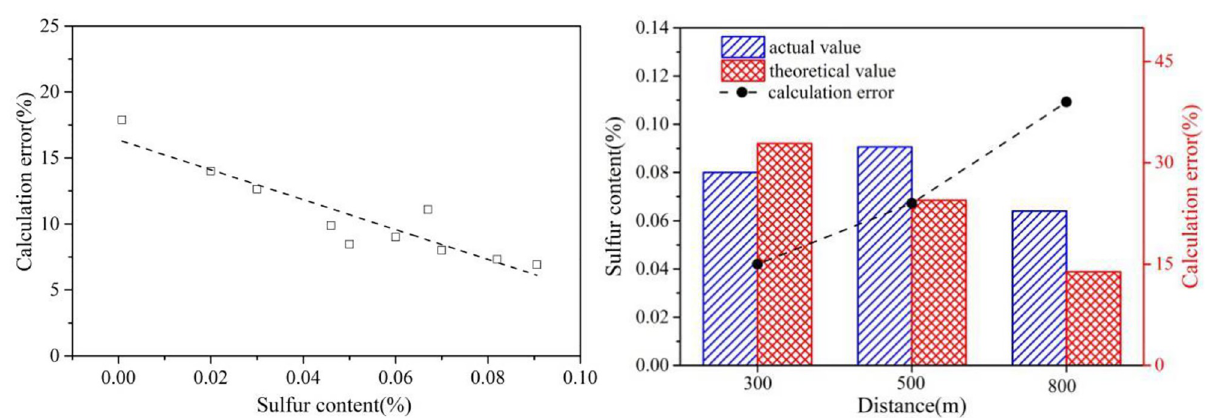
Fig 15. Influence of (a) sulfur content, (b) monitoring distance on the calculation